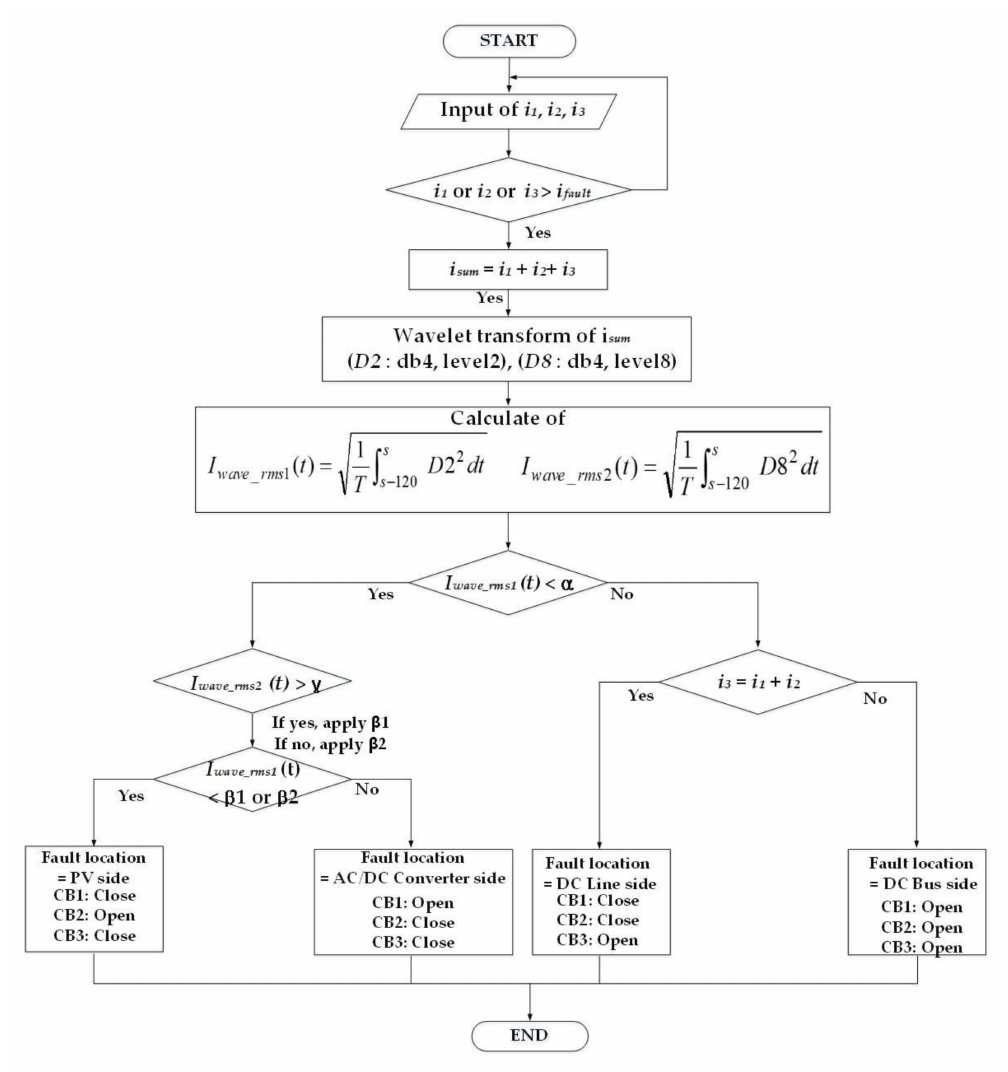
Figure 10. Flow chart of new protection